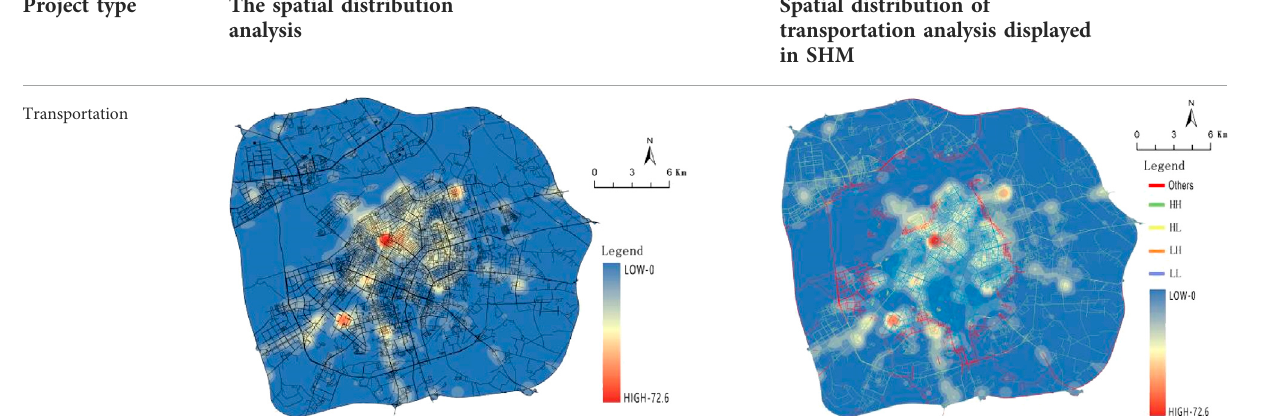
TABLE 4 Spatial distribution of single infrastructure (Transportation) in